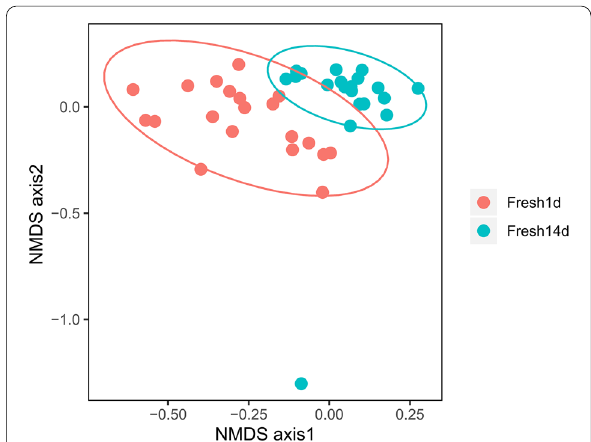
Fig. 1 None-metric multidimensional scale analysis based on Bray–Curtis distance. ANOSIM analysis of the samples on d1 and d14, where bacterial communities in dairy cow feces are grouped by lactation period in feces. Analysis was conducted using a Bray–Curtis metric based on operational taxonomic units (R 2 Fresh1d indicates fecal microbiota samples from cows on d1, Fresh14d indicates fecal microbiota samples from cows on